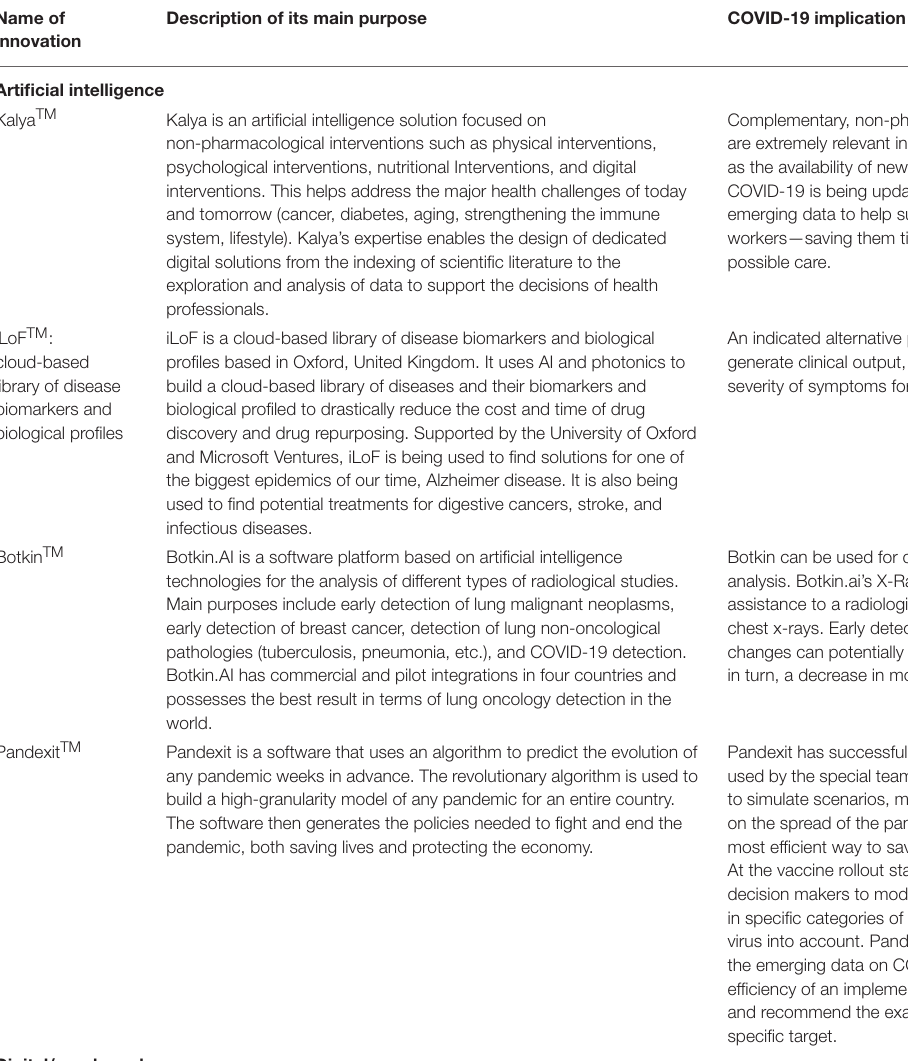
TABLE 1 | Shortlisted innovations and their potential to help with COVID-19